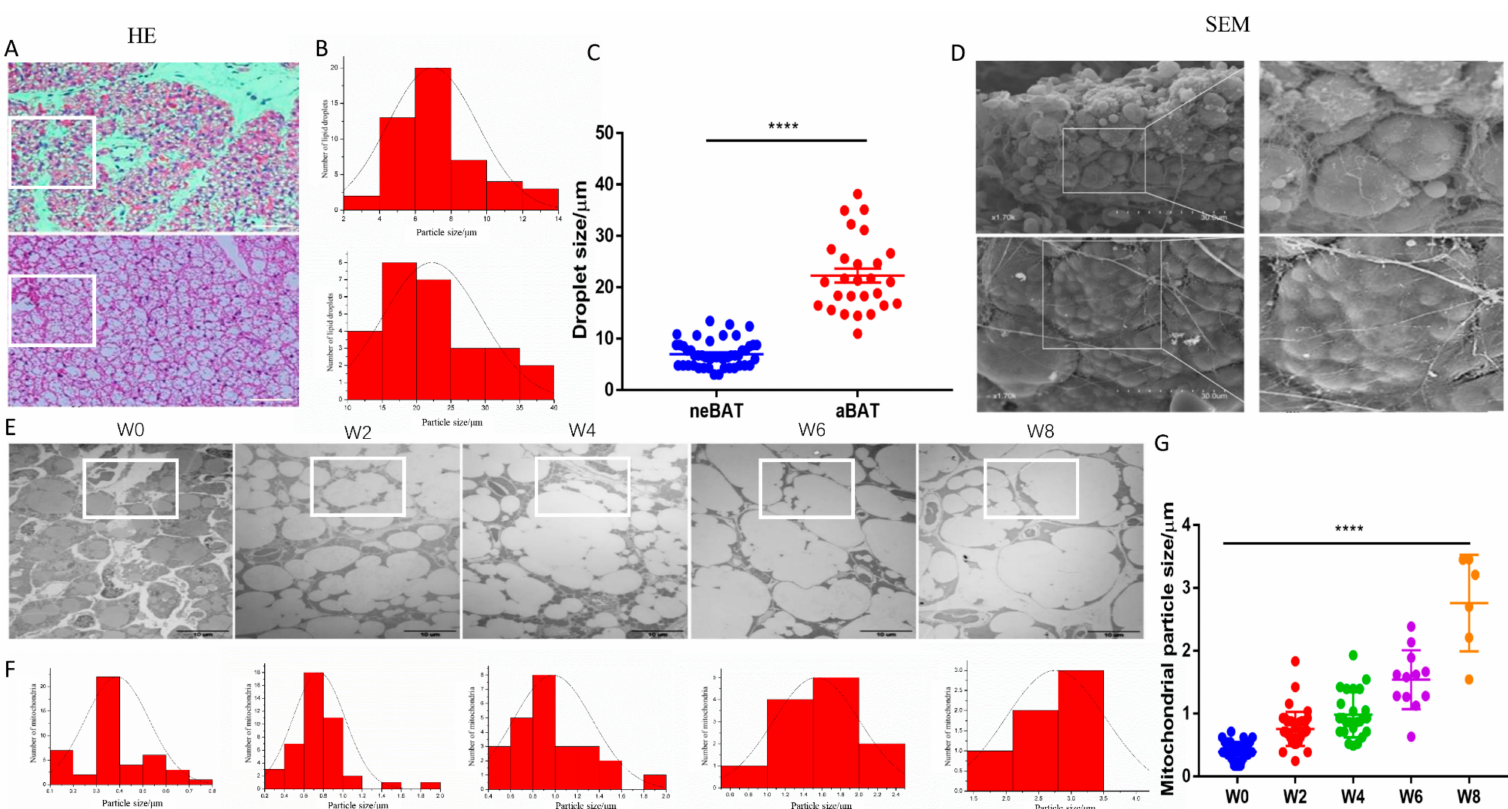
Figure 1. The morphology of aBAT and neBAT. ( A ) H&E staining (scale bars, 100 µ m) of neBAT and aBAT. ( B , C ) The size distribution of the lipid droplets is shown in the white box of the figure ( A ). ( D ) SEM (scale bars, 30 µ m) of neBAT and aBAT (the second right-hand image is a local enlargement of the second image on the right). ( E ) TEM of BAT on week 0 (W0), week 2 (W2), week 4 (W4), week 6 (W6), and week 8 (W8) after pregnancy. The first row is 3000 × (scale bars, 10 µ m). ( F , G ) The mitochondrial particle size distribution in the white box of the figure above, respectively. Data are presented as the mean ± sem. The significance of the di ff erence was set at **** p < 0.0001 relative to